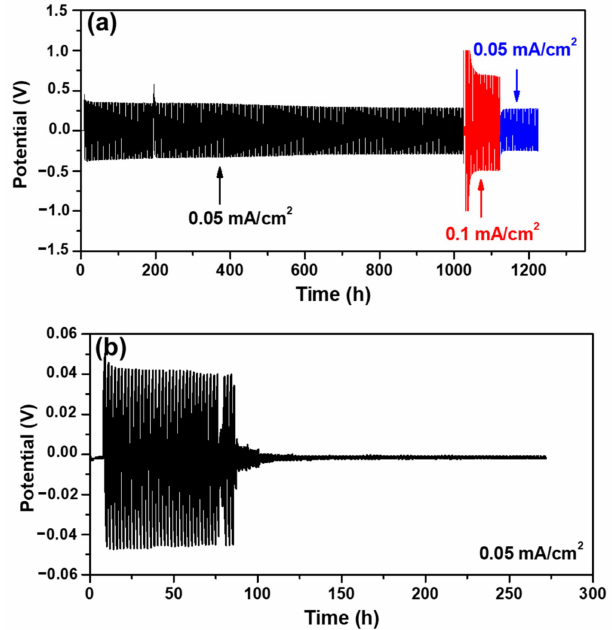
Figure 7. Galvanostatic cycling profiles for the Li|Li symmetrical cell with ( a ) PEO- b -PDM 15 -dTFSI- 1/5 and ( b ) PEO/LiTFSI-1/5 electrolytes at 60 ◦